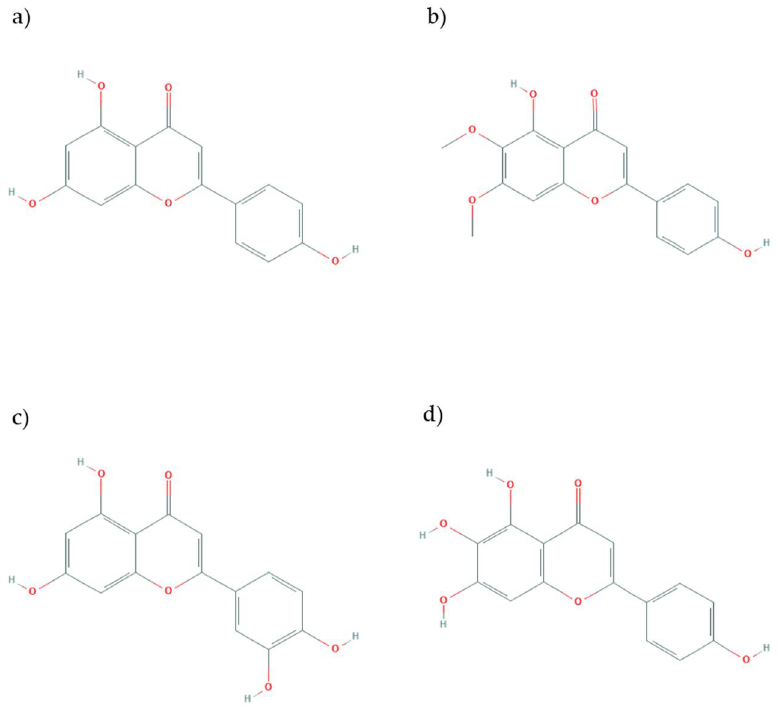
Figure 2. Common aglycone flavones in Lamiaceae plants ( a ) apigenin, ( b ) cirsimaritin, ( c ) luteolin,